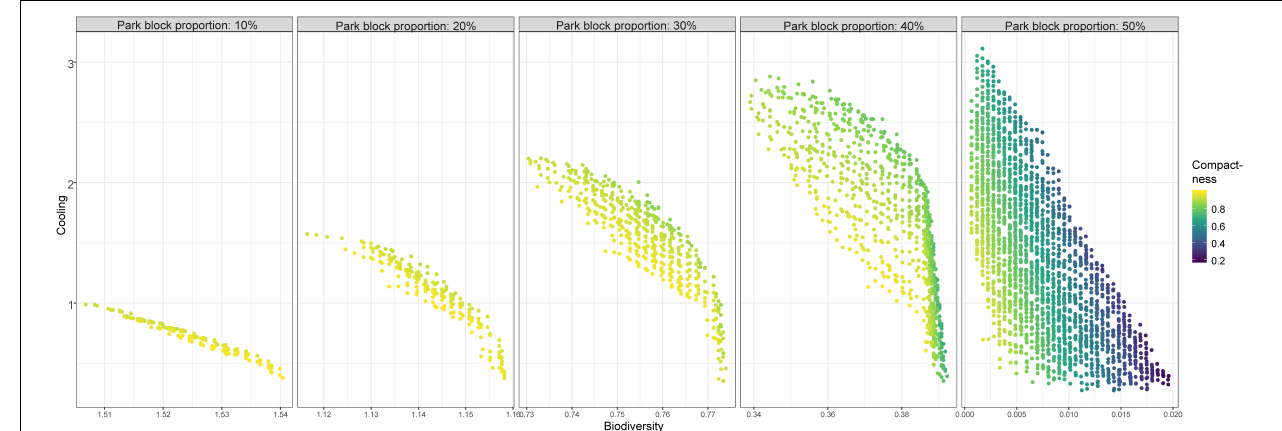
FIGURE 4 | Fronts of non-dominated solutions for cooling, biodiversity, and compactness differentiated by landscape composition with different shares of park blocks (10–50%) in the landscape. Note that the absolute values for biodiversity strongly depend on the share of park blocks in the